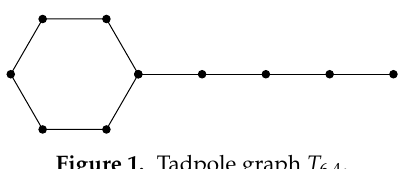
Figure 1. Tadpole graph T 6,4 .